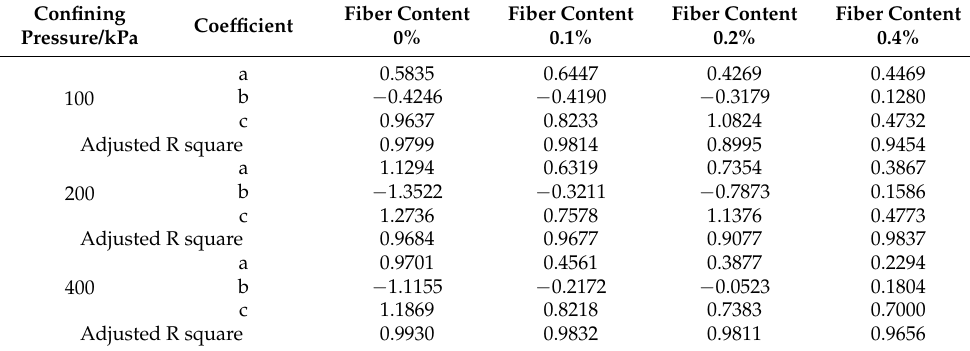
Table 8. Table of constitutive equation coefficients of fiber-cement soil under confining